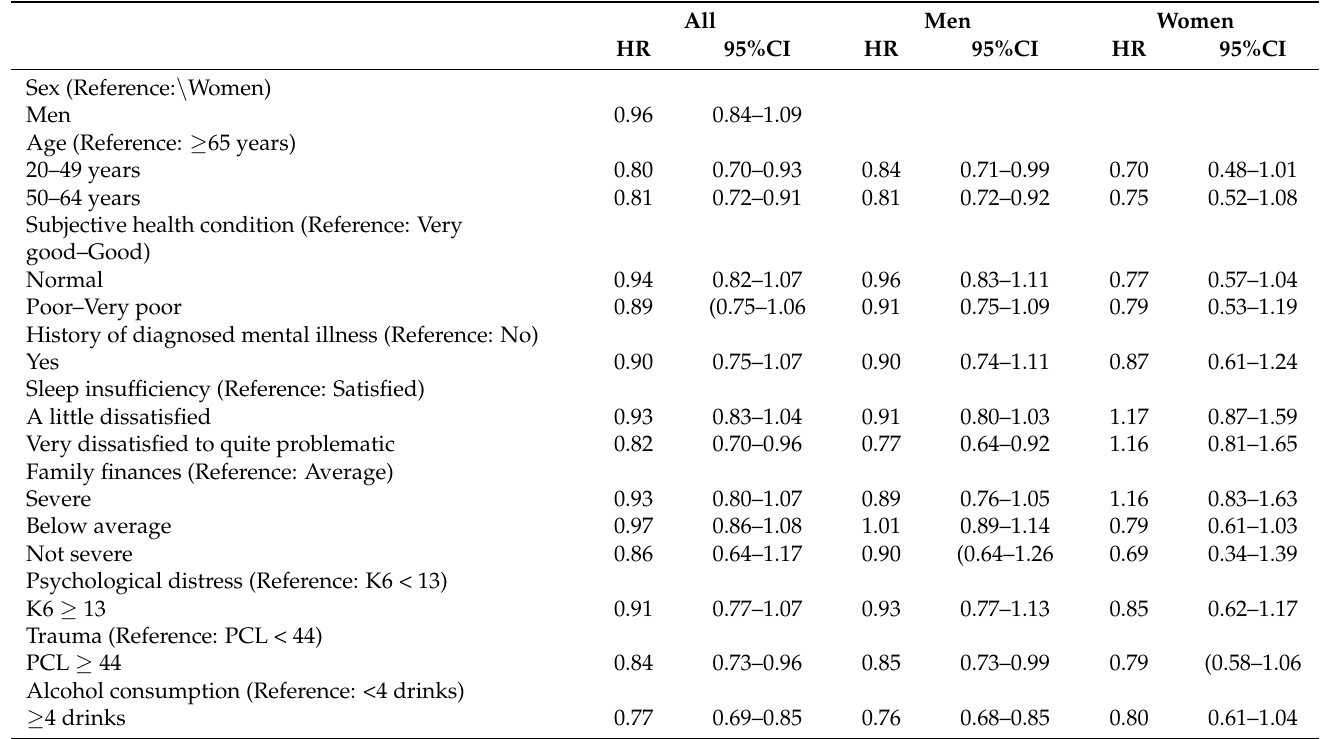
Table A6. Multivariate Cox proportional hazard model: Possible risk factors for problem drinking according to increase in CAGE